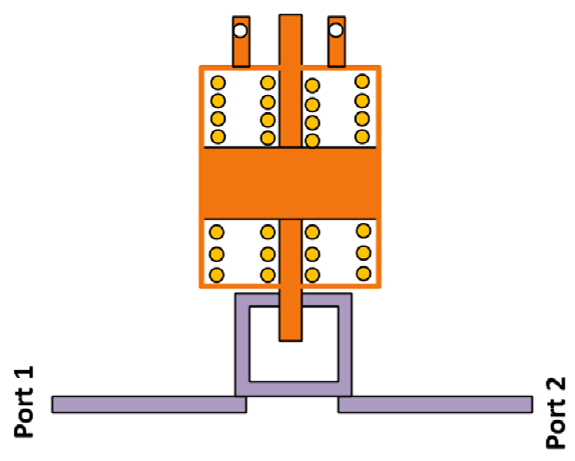
Figure 2. The photograph of the